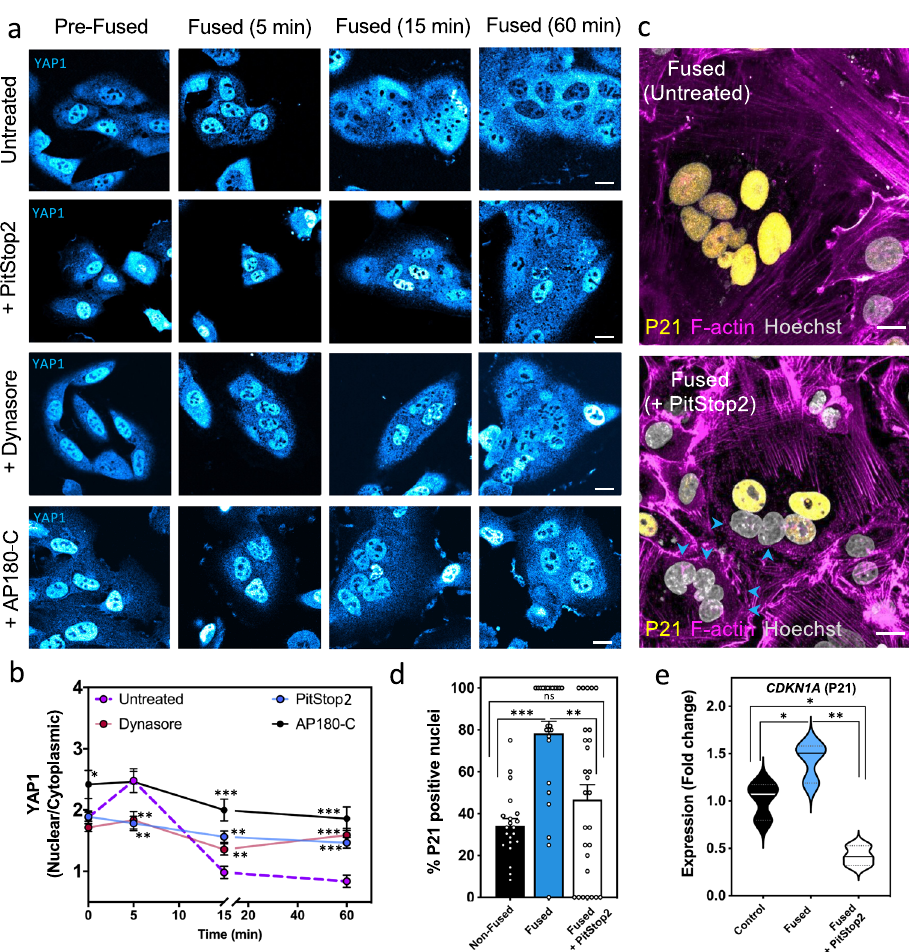
Fig. 5 YAP1 inhibition and cell-cycle arrest after cell fusion depend on active clathrin-mediated endocytosis. a SUM-159 cells, transfected with VSV-G, were incubated with inhibitors of endocytosis (PitStop2 or Dynasore) or transfected with a dominant negative form of the clathrin adapter AP-180 (AP180- C), a speci fi c inhibitor of CME. Cells were then induced to fuse, fi xed at indicated time points, immunostained with anti-YAP1 antibody and imaged by confocal microscopy to determine the YAP1 localization. b The ratio of nuclear to cytoplasmic YAP1 was measured at each timepoint after fusion in control (untreated) or endocytosis inhibited cells washed with fusion buffer. Error bars represent the SEM of cells examined over three independent experiments. For untreated cells (magenta line): n = 44, n = 19, n = 21, and n = 23 cells at 0, 5, 15, and 60 min, respectively. For Dynasore treated cells (red line): n = 38 (ns), n = 25 (** p = 0.0092), n = 32 (** p = 0.0095), and n = 31 cells (*** p < 0.0001) at 0, 5, 15, and 60 min, respectively. For PitStop2 treated cells (blue line): n = 101 (ns), n = 36 (** p = 0.0021), n = 44 (** p = 0.0003), and n = 50 cells (*** p < 0.0001) at 0, 5, 15, and 60 min, respectively. For cells transfected with AP180-C (black line): n = 24 (* p = 0.019), n = 24 (ns), n = 25 (*** p < 0.0001), and n = 28 (*** p < 0.0001) at 0, 5, 15, and 60 min, respectively. p values represent the differences between the control and each endocytic inhibitor at the indicated time point. c Confocal images of P21- positive nuclei in untreated and PitStop2 treated cells fi xed 24h after fusion. Arrow heads points at nuclei within fused cells negative for P21. d Quanti fi cation of the percentage of P21-positive nuclei in both fused (blue bar) and non-fused (black bar) cells in the untreated samples and the fused cells in the PitStop2 treated samples (white bar) are graphed. Error bars represent the SEM, n = 21, n = 25, and n = 28 cells examined over three independent experiments for non-fused, fused, and PitStop2 treated fused cells, respectively. *** p < 0.0001, and ** p = 0.0012. e Violin plots depict the fold change in CDKN1A (P21) expression measured by qRT-PCR and compared in unwashed control cells (black), fused cells (blue), and fused cells treated with PitStop2 (white). n = 3 independent experiments. * p = 0.0412, * p = 0.0109, and ** p = 0.0007. ns not signi fi cant ( p > 0.05). Statistical signi fi cance calculations were performed using a two-tailed unpaired Student ’ s t test. Scale bar size = 10 μ